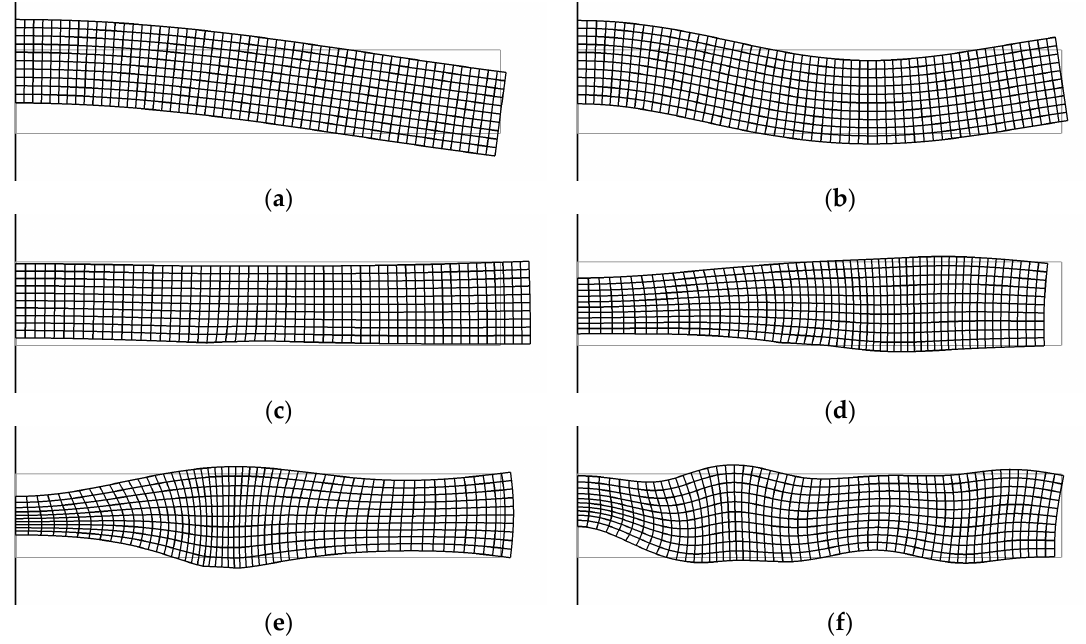
Figure 6. Distribution of mechanical displacements inside the disk resonator corresponding to different types of oscillations at different excitation frequencies: ( a ) flexural mode F0, f = 26117 Hz; ( b ) flexural mode F1, f = 97574 Hz; ( c ) radial mode R0, f = 124871 Hz; ( d ) radial mode R1, f = 314055 Hz; and ( e ) thickness extensional mode TE0, f = 469336 Hz; and ( f ) thickness extensional mode TE1, f = 609629 Hz. The vertical line to the left indicates the axis of the disk.